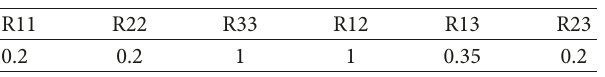
Table 4: Yield stress ratios.